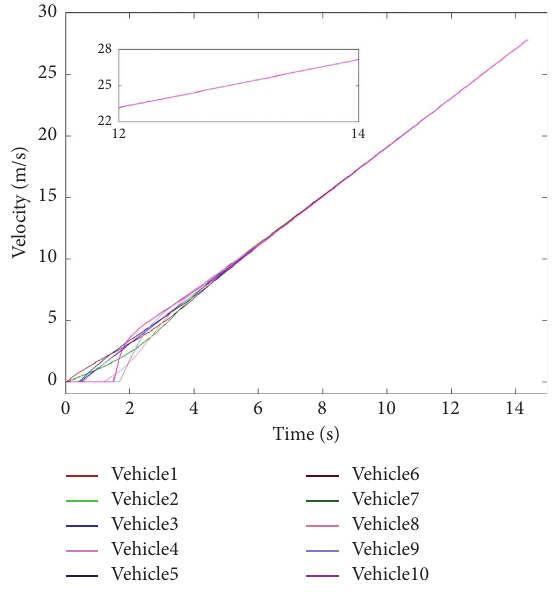
Figure 5: Velocity history under proposed controller (35).